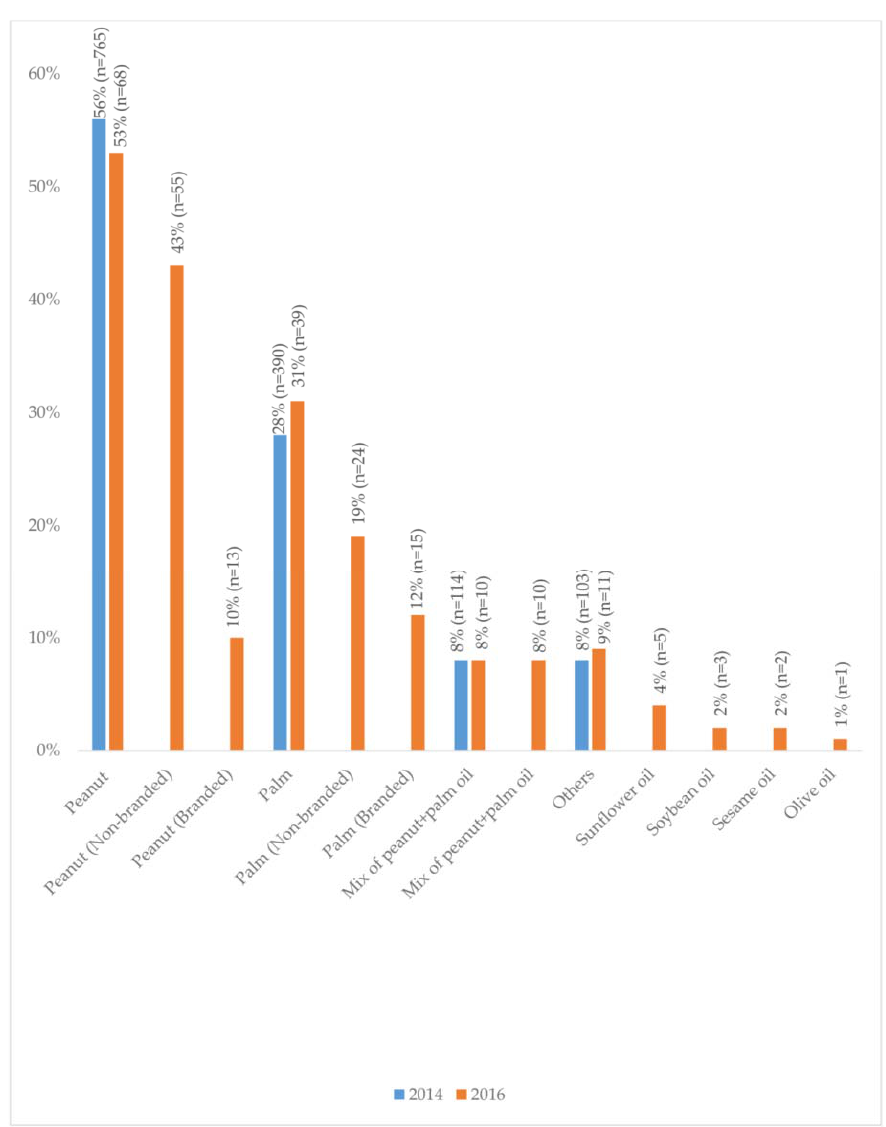
Figure 1. The proportion of participants using various vegetable oils for cooking purposes in the Yangon region between 2014 and 2016.